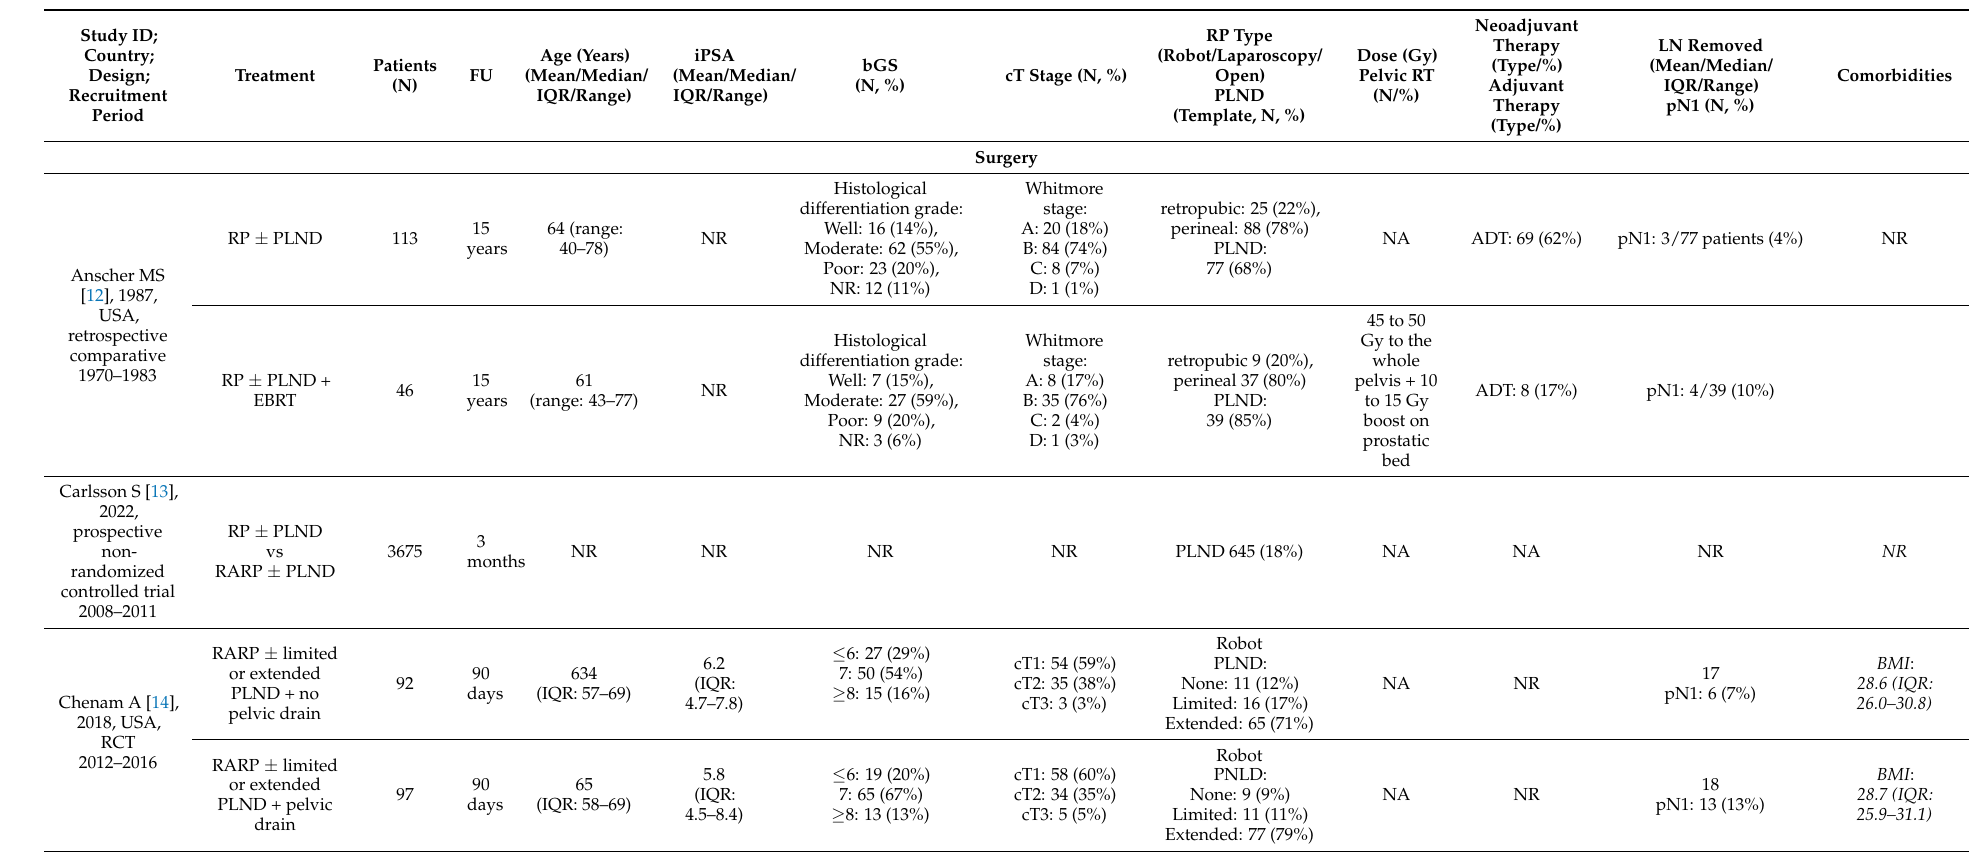
Table 1. Overview of included